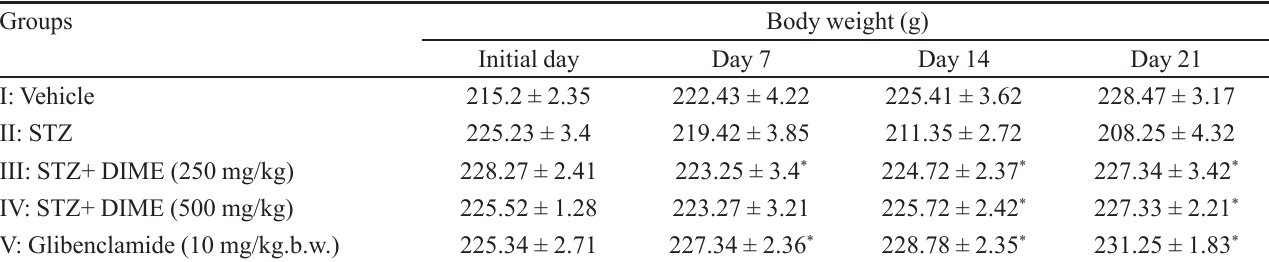
TABLE II - Effect of DIME on body weight in diabetic rats Groups